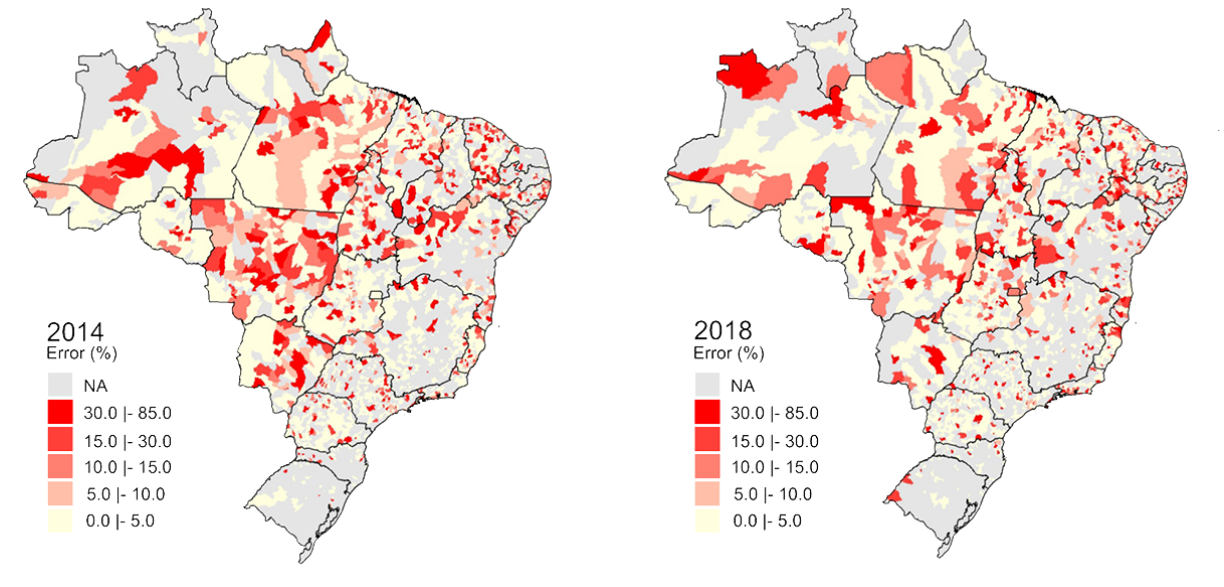
Figure 6. Geographic leprosy misclassification distribution in Brazilian municipalities. NA: not available.